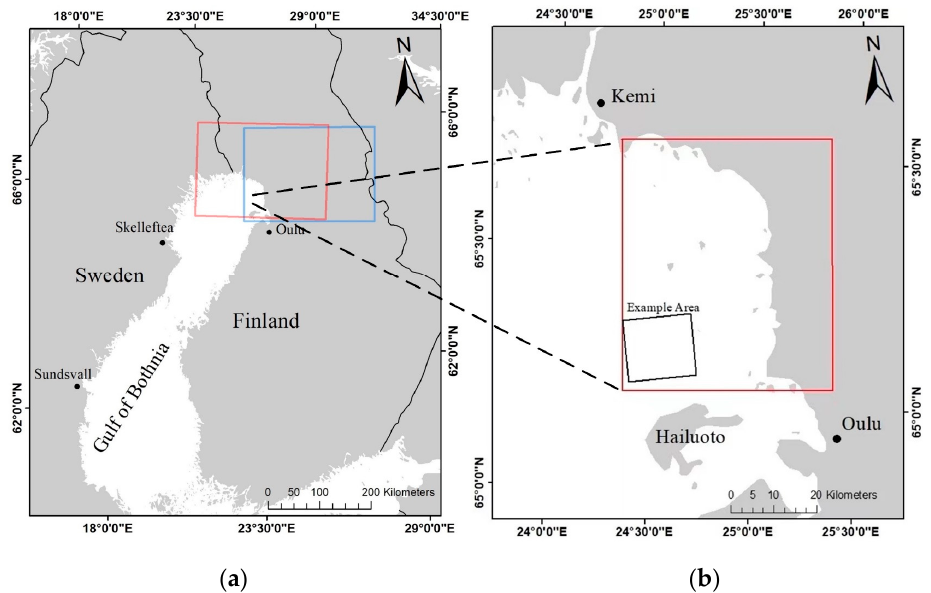
Figure 1. An overview of the study area: ( a ) Coverage of Sentinel-1 radar data, with the red and blue boxes representing the coverage of the Sentinel-1 radar data from No. 51 orbit and No. 153 orbit, respectively; ( b ) Study area, with the red box representing the study area and the black box representing the example area.